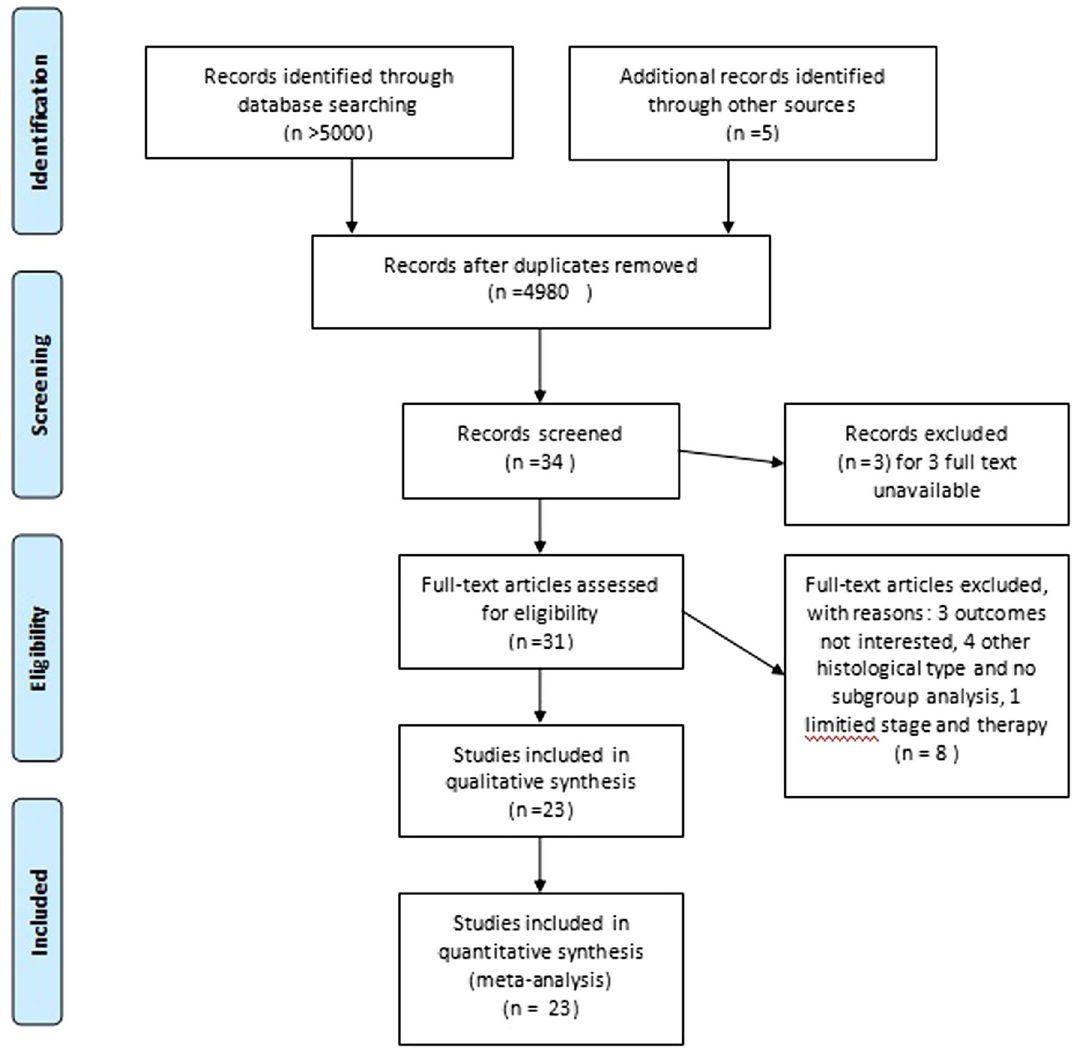
Figure 1. Literature search flow